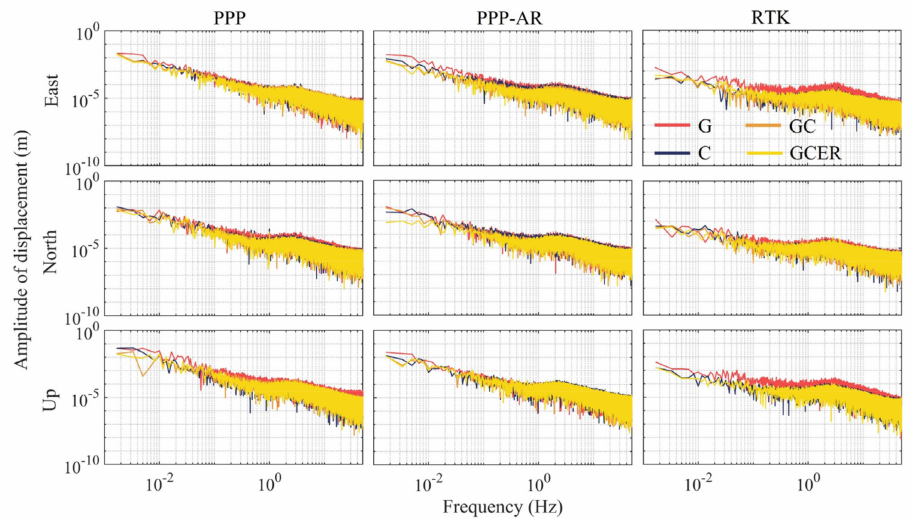
Figure 4. Amplitude–frequency spectra of 3D displacement results from G, C, GC, and GCER observations and PPP, PPP-AR, and RTK techniques in the stationary test. The upper, middle, and lower panels represent displacements in the East, North, and Up directions, respectively, while the left, middle, and right columns represent results from PPP, PPP-AR, and RTK,